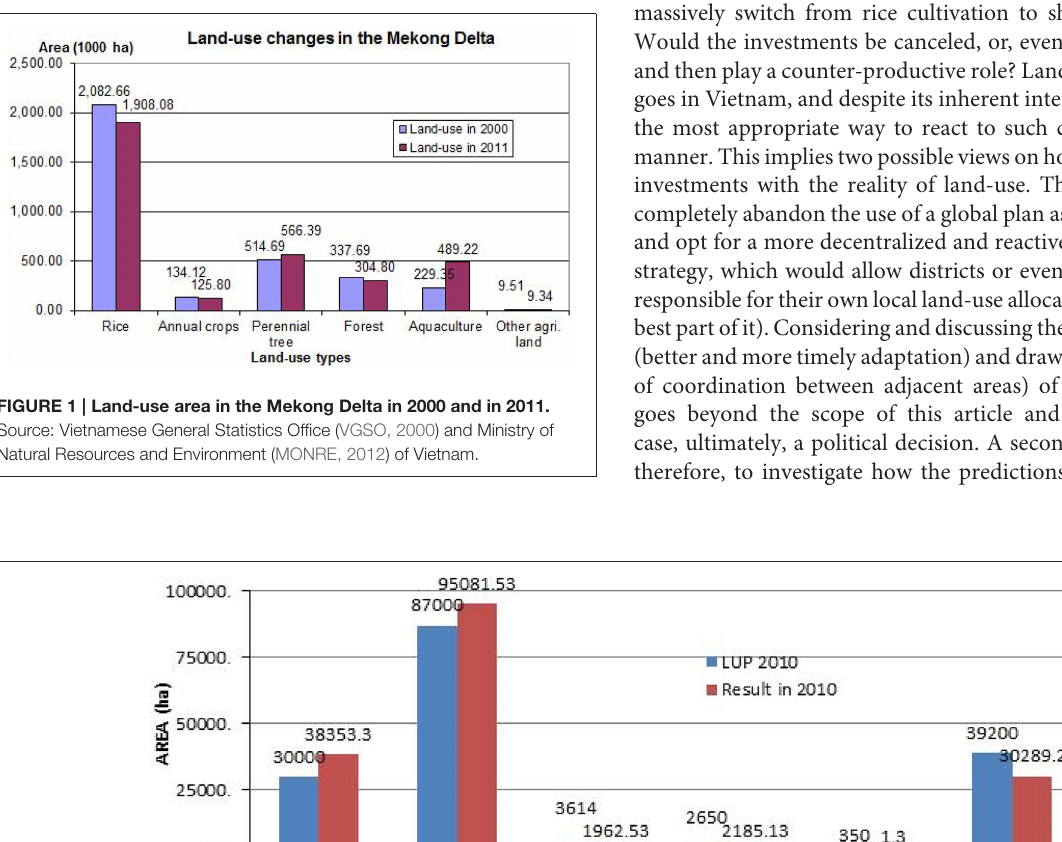
Frontiers in Environmental Science |